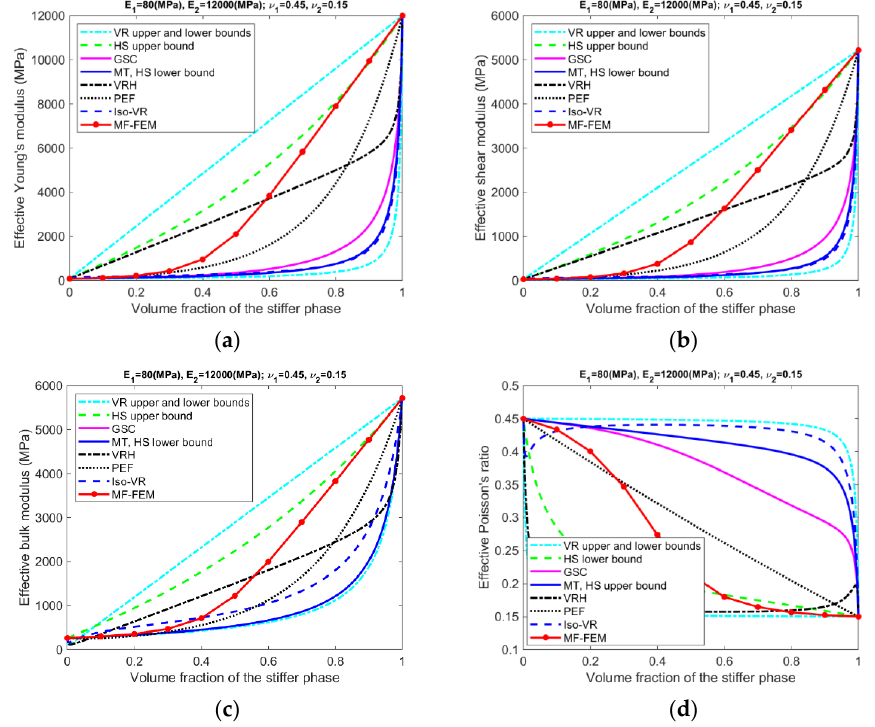
Figure A3. Composite #3—large contrast in phase Young’s modulus and small contrast in phase Poisson’s ratio. ( a ) Young’s modulus; ( b ) shear modulus; ( c ) bulk modulus; ( d ) Poisson’s ratio.